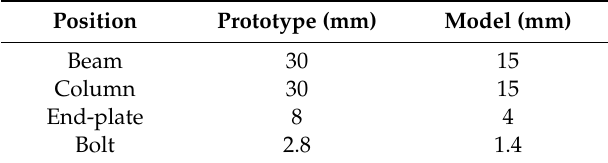
Table 6. Model and prototype unit dimensions.